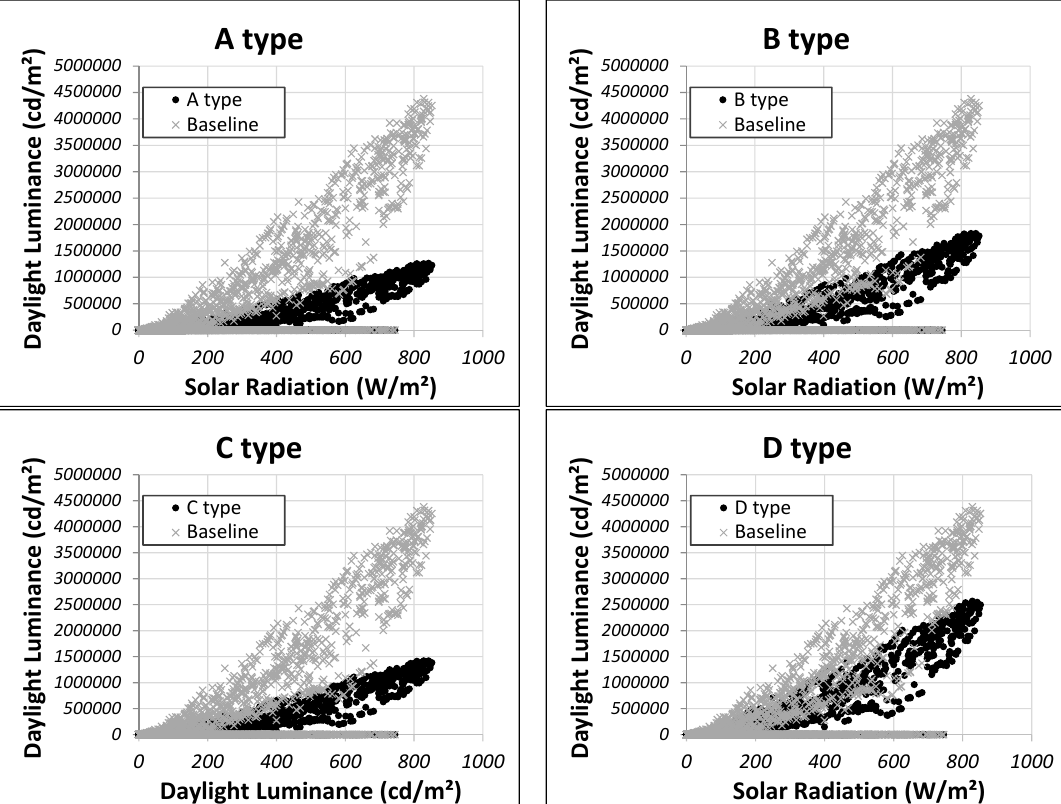
Figure 13. Annual daylight luminance analysis result by PDLC film type.